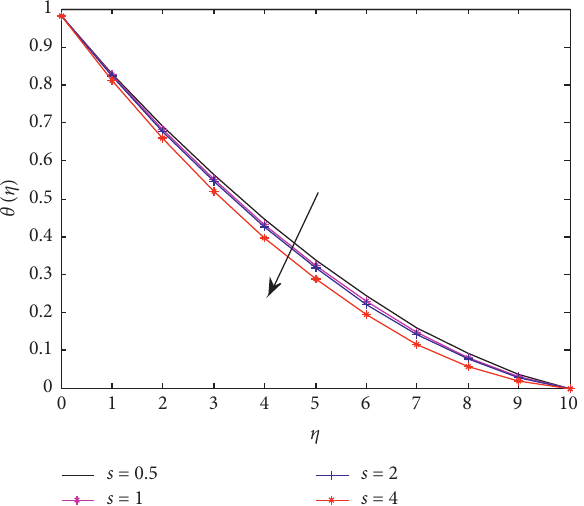
Figure 8: Variation of temperature against various values of s when Pr � 0 . 72 , Ω � M � λ � R � 1, c � 0 . 2, β � 0 . 2, and Ec � 0 . 1.